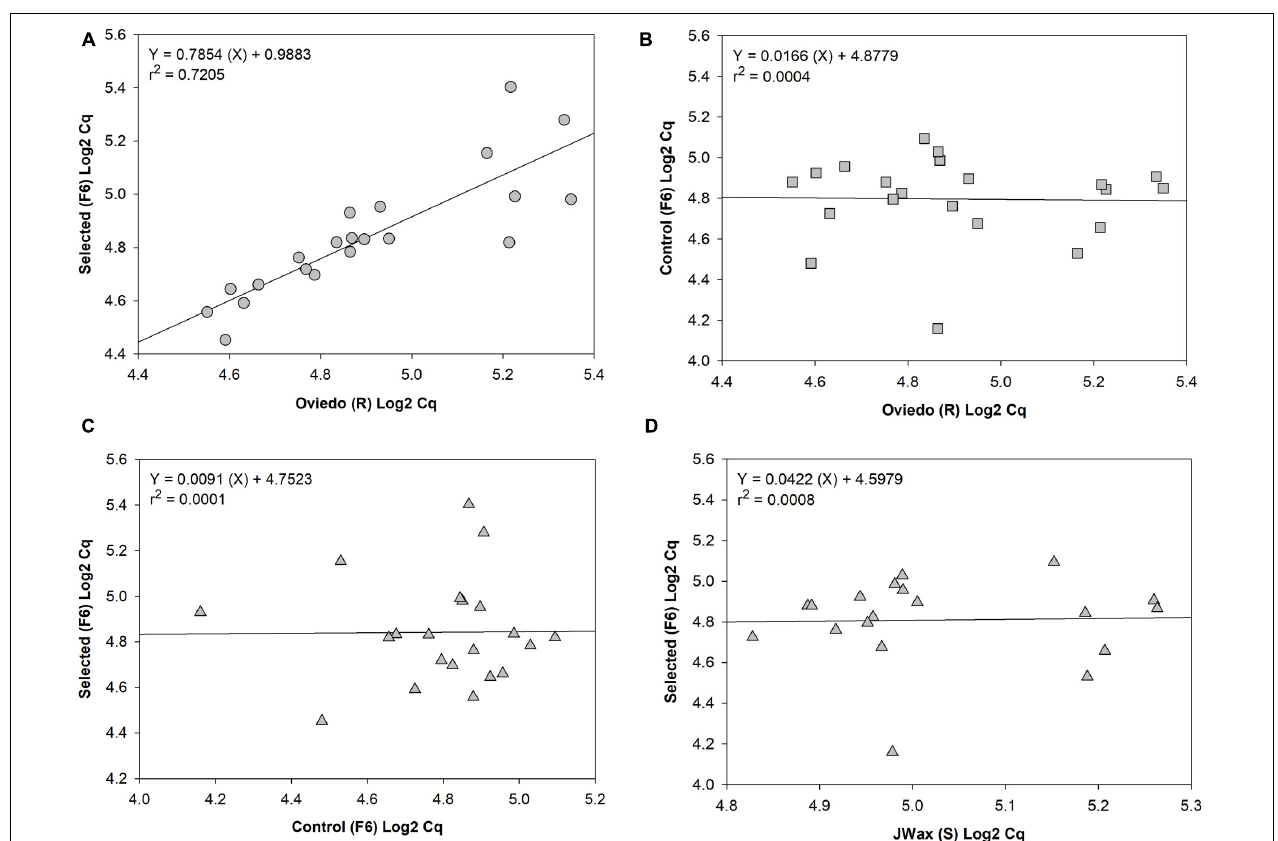
FIGURE 6 | Regression analyses of qRT-PCR relative expression data for 21 significant differentially expressed contigs. Results show (A) well-correlated gene expression between the selected-F6 and highly resistant Oviedo-R strains, but no correlation when comparing (B) Oviedo vs. Control-F6, (C) Control-F6 vs. Selected-F6, or (D) JWax-S vs. Selected F6. All C q data were Log2 transformed before performing